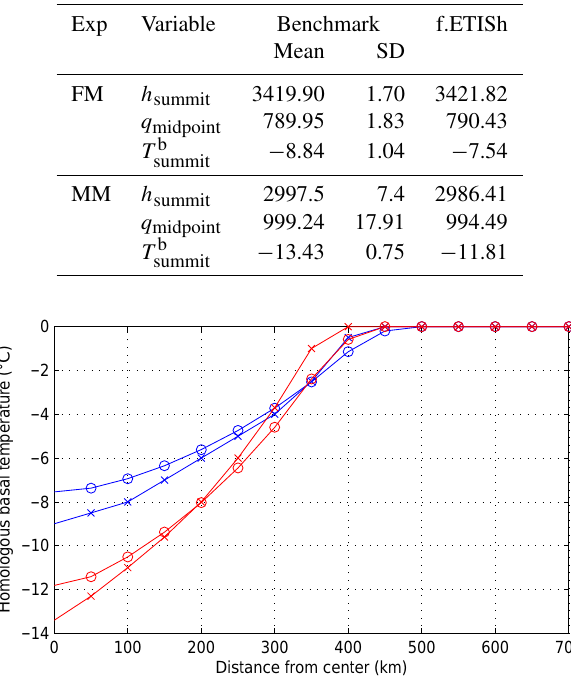
Figure A1. Homologous basal temperatures along the central line according to the EISMINT-I experiment calculated with f.ETISh (circles) and according to the EISMINT-I benchmark (crosses) for the fixed margin (blue) and moving margin (red)